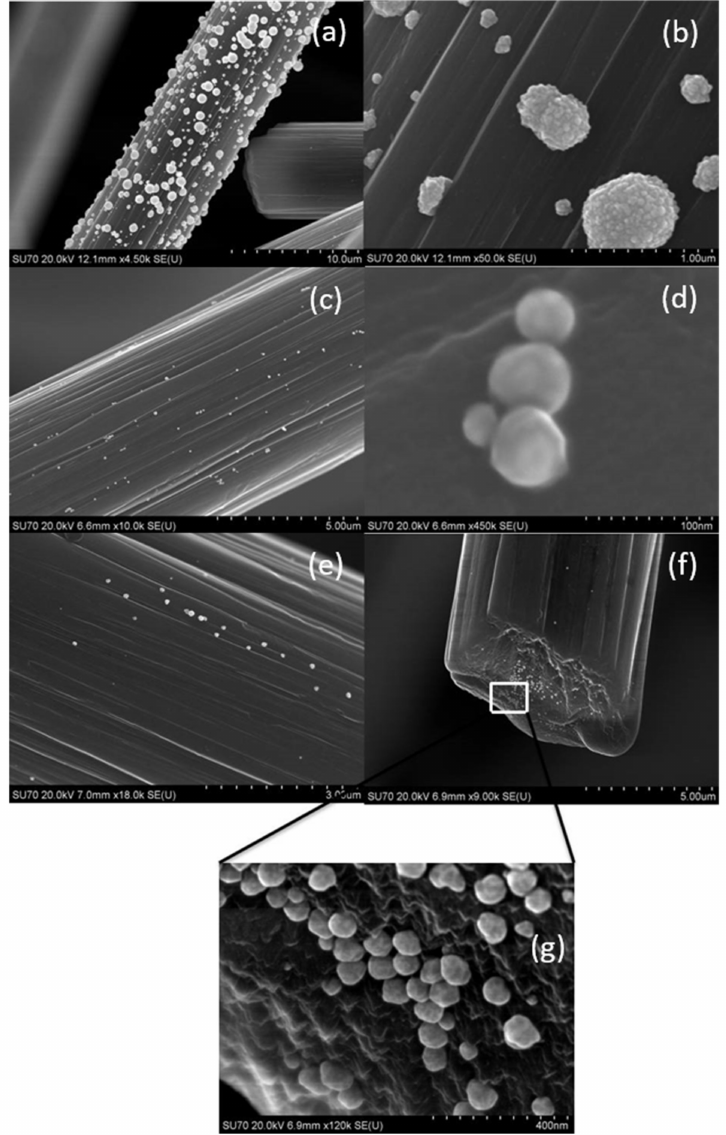
Figure 5. SEM analysis of activated carbon fibers covered by colloidal gold obtained during adsorp- tion process carried out in the batch reactor: AS4 ( a , b ); AS5 ( c , d ); AS6 ( e – g ). Conditions: C 0, Au(III) = 0.3 mM, C 0, H2Asc = 0.6 mM, addition of PVA (samples AS4, AS6), amount of the activated carbon fibers 0.025 g/ 25 mL of the solution, T = 20 ◦